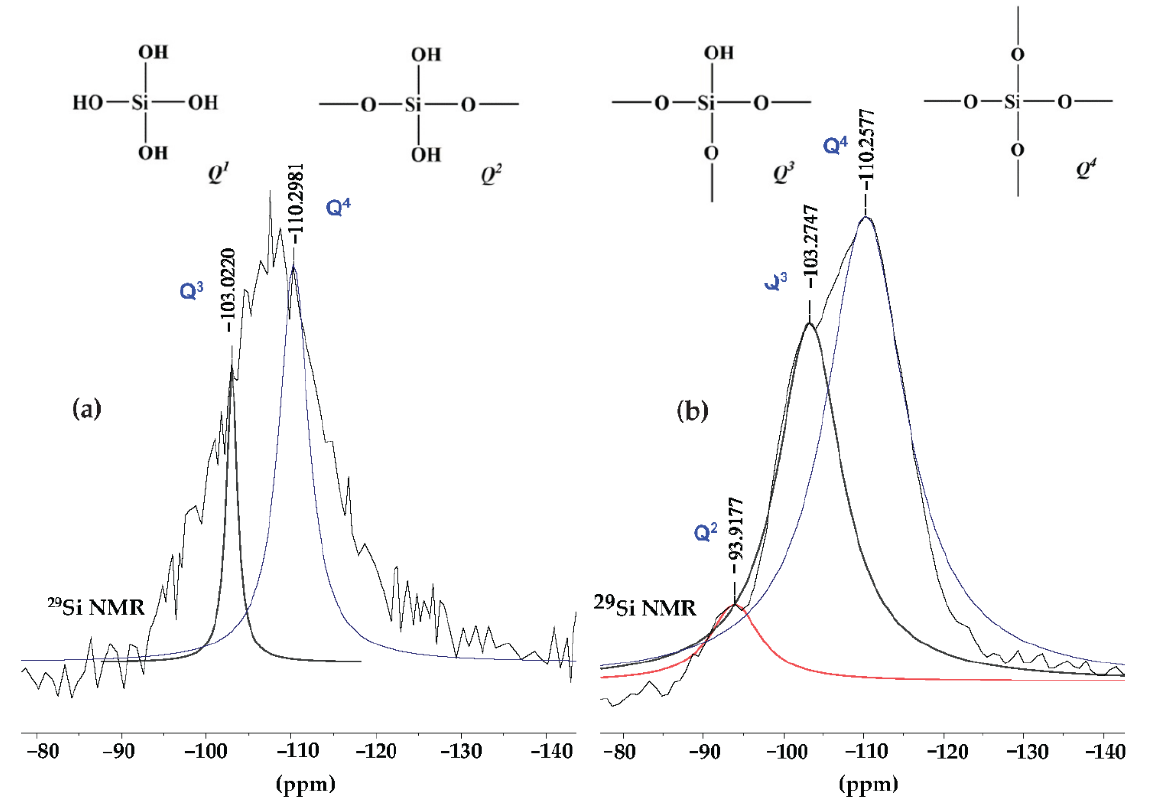
Figure 5. 29 Si-NMR patterns of ( a ) SiO 2 and ( b ) Ti 50 Si 50 oxide. FTIR spectra of TiO 2 , SiO 2 , and Ti 50 Si 50 oxides synthesized at various pH values are shown in Figure 6. TiO 2 and all Ti 50 Si 50 oxides displayed a prominent band at 400 to 700 cm − 1 in their FTIR spectra, which corresponded to the bending and stretching mode of Ti–O–Ti and was characteristic of well-ordered TiO 6 octahedrons [30].